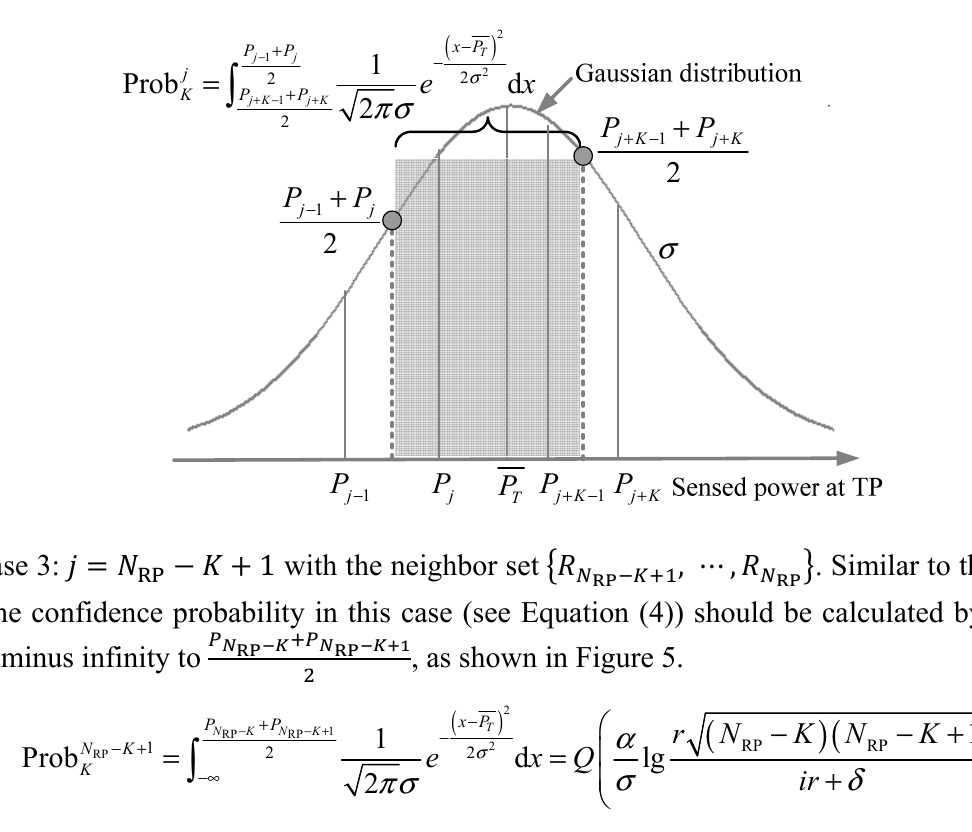
Figure 4. Confidence probability of case 2 in equal-weighted RLSNs.